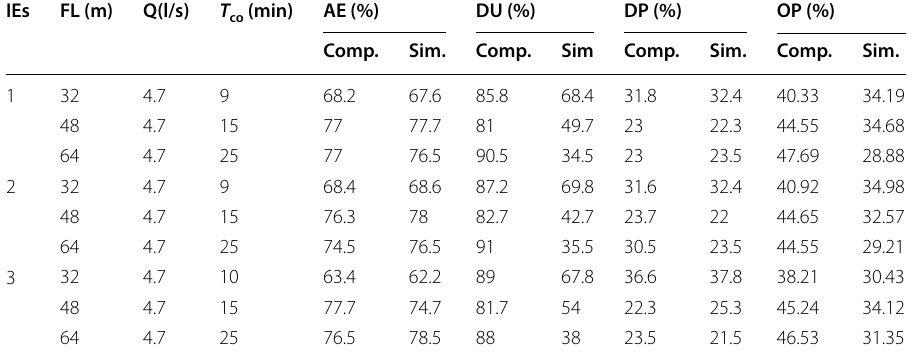
Comp. Comp. Sim. Comp. Sim.